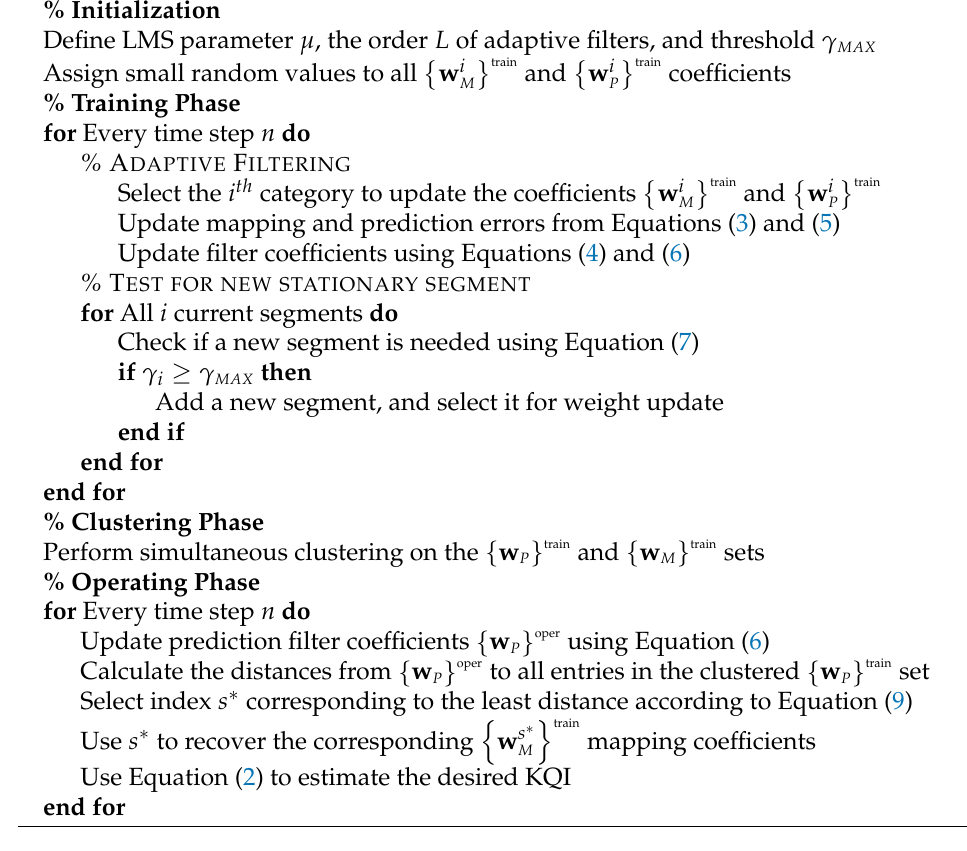
Algorithm 1 KQI modeling using LMS multivariate adaptive filtering as